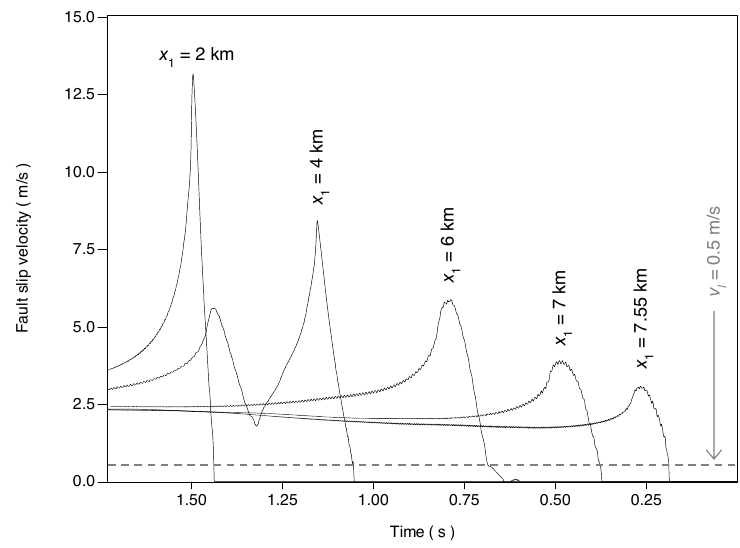
Figure 8. Time evolution of the fault slip velocity v at difference spatial coordinates (indicated near each slip velocity peak). The results per- tain to the 2–D simulation of Figure 7. The horizontal gray dashed line indicates the greater threshold value of v employed in Figure 7 to = 0.5 detect the location of the rupture front ( v l